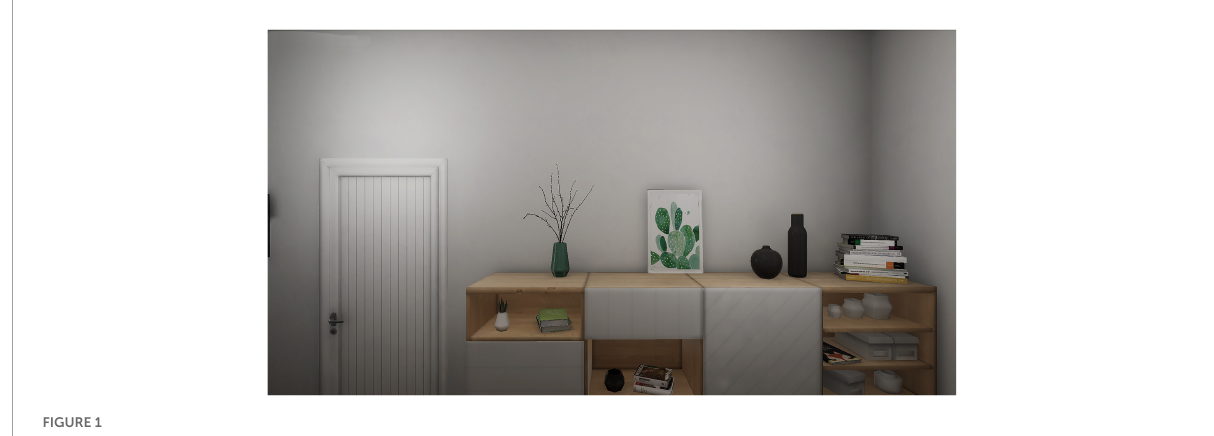
FIGURE1 Neutral